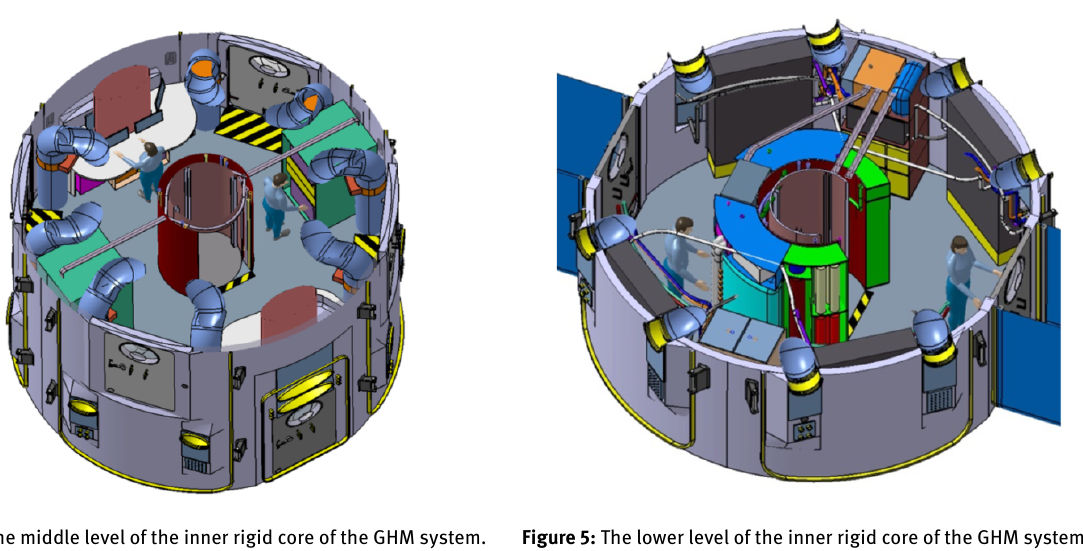
Figure 3: The upper level of the inner rigid core of the GHM